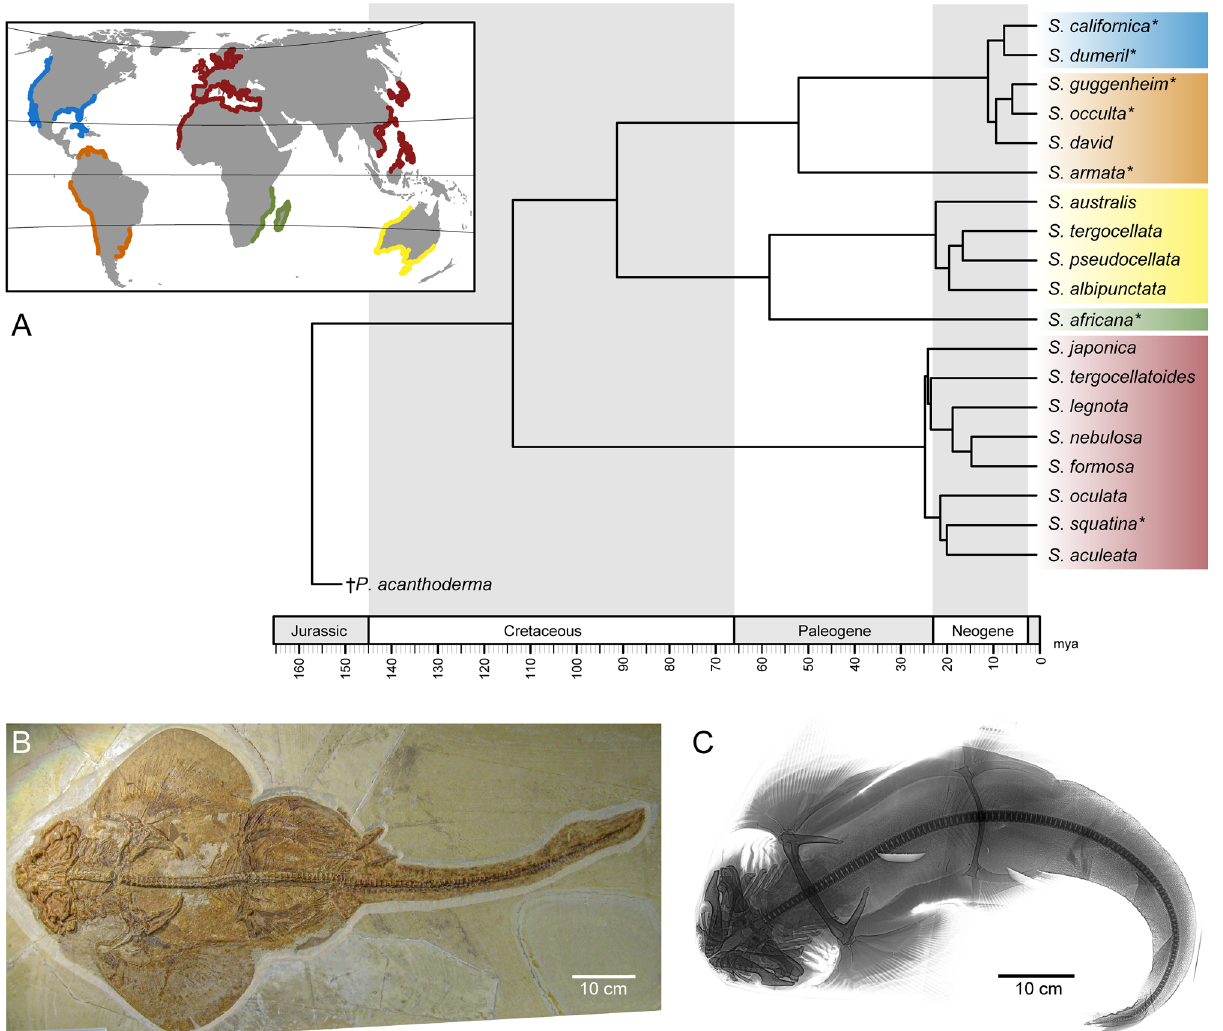
Figure 1. ( A ) Distribution and phylogeny of extant angel sharks worldwide, the colours correspond to the clades highlighted in the phylogeny. Phylogeny of the angel shark species, modified from Stelbrink et al. 17 colour code indicates the respective clade, *represents the species used for the present study. ( B ) Fossil angel shark † Pseudorhina acanthoderma , adult specimen (SMNS 8621441), ( C ), Holotype X-Ray of Squatina africana (BMNH1906.11.19.21), modified to fit the figure and downloaded from https ://data.nhm.ac.uk/objec t/15711 224-7ceb-4829-95cb-4286f c14bc ad/15912 28800